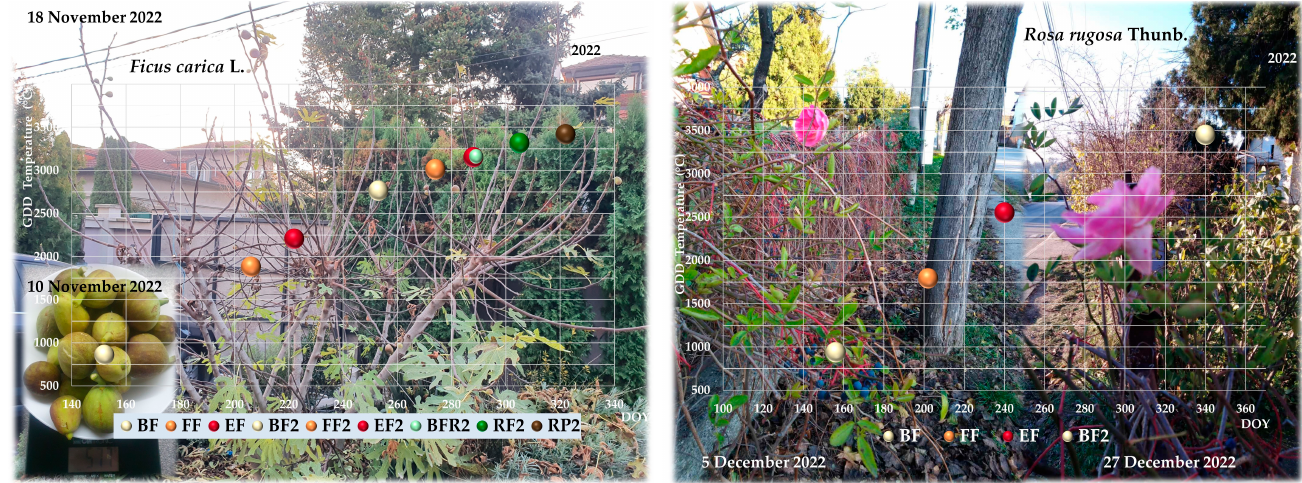
Figure 14. Phenological observations: GDD and DOY for the beginning of first flowering (BF), full first flowering (FF), the end of first flowering (EF), the beginning of second flowering (BF2), full second flowering (FF2), the end of second flowering (EF2), RF2 (second appearance of first ripe fruits), and RP2 (second fruit ripening) for Edible Fig (left) and Rugosa Rose (right) in 2022.